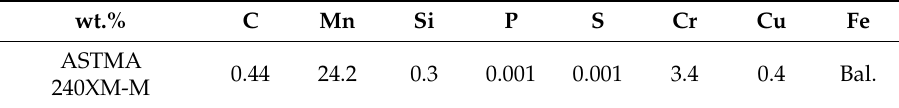
Table 1. Chemical composition of the present high manganese steel